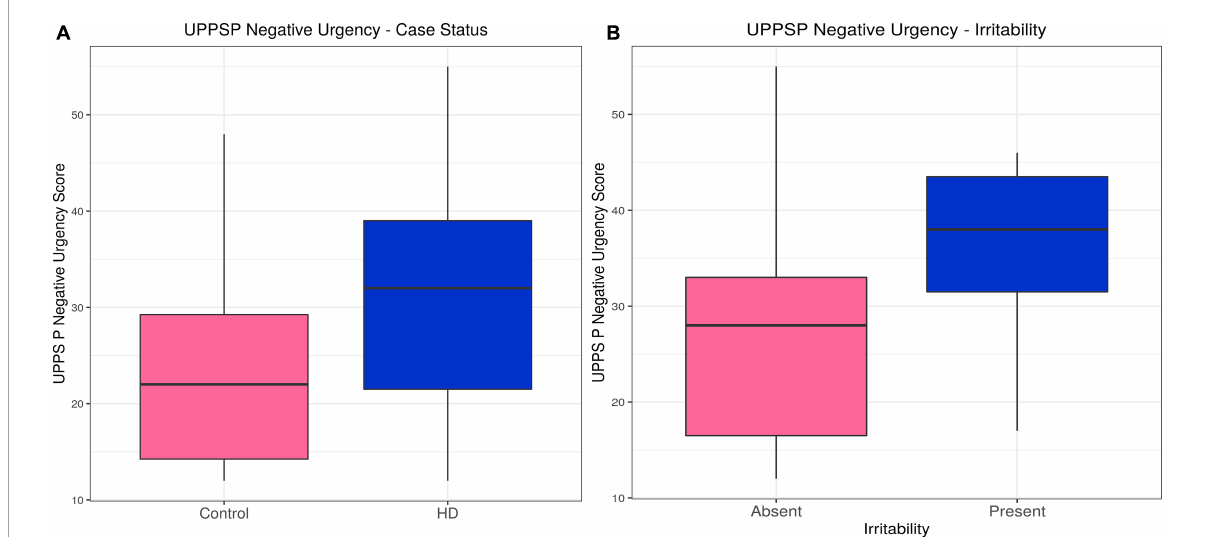
FIGURE1 UPPS P Negative Urgency–Effects of case status and irritability status. Box and whisker plots (median, interquartile range, and outliers as individual points). (A) Group differences between Huntington’s (HD) cases and control participants. (B) Group differences between irritable and non-irritable HD cases. UPPS P, Urgency (Negative), (lack) Premeditation, (lack) Perseverance, Sensation Seeking, Positive